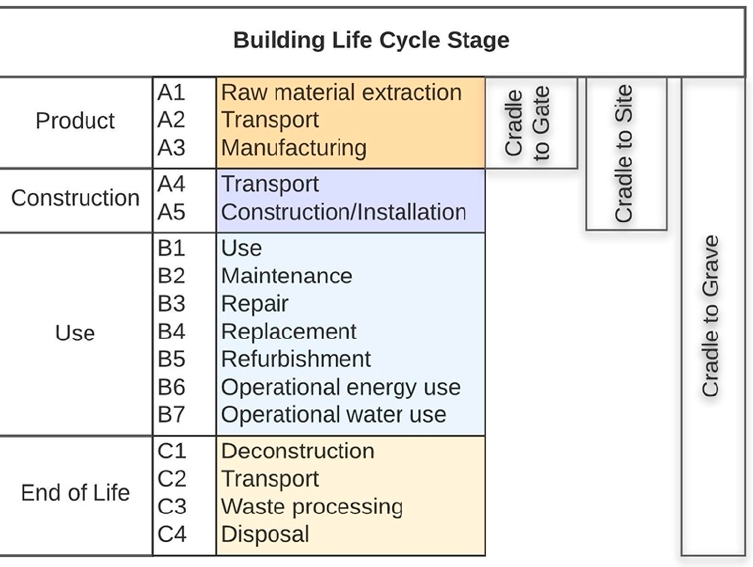
Figure 1. Embodied carbon definition and life cycle stages (adapted from [35].